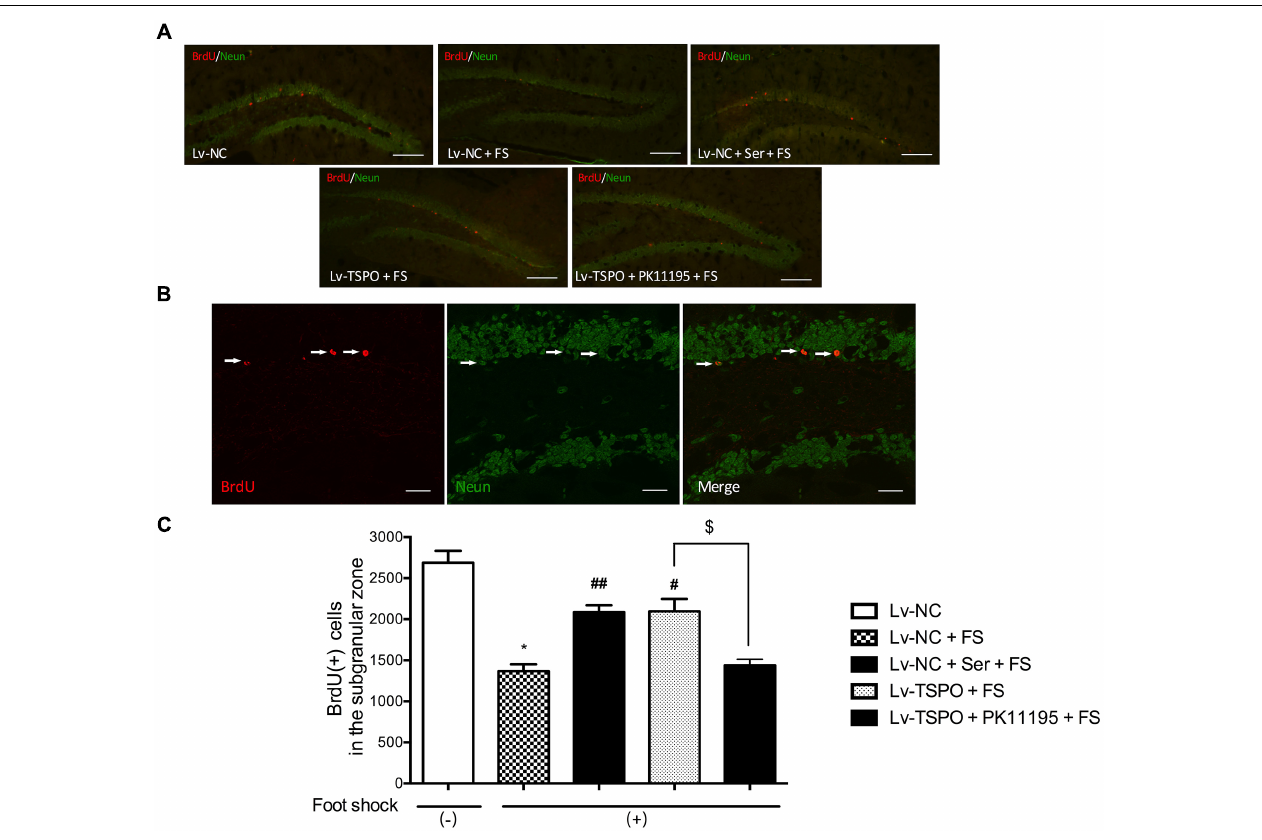
FIGURE 3 | Effect of TSPO overexpression in the DG on the number of BrdU-positive cells in the hippocampus in mice after electric foot-shocks. (A) A confocal laser-scanning microscope micrographs of BrdU-labeled cells (red) in the dentate gyrus of hippocampus. Scale bar = 200 µ m. (B) NeuN (green) and BrdU (red) co-labeled cells in the dentate gyrus were photographed and quantified under confocal microscope. Scale bar = 50 µ m. (C) Statistical analysis showed a significant decrease of the number of BrdU-positive cells in mice of foot-shock exposure (LV-NC + FS) compared with non-foot-shocked mice (Lv-NC), whereas it was prevented in the group of Lenti-GFP-TSPO injection (Lv-TSPO +FS). The improvement of Lv-TSPO was reversed by PK11195 (Lv-TSPO + PK11195 +FS). Data were presented as the means ± SEM ( n = 3). ∗ P < 0.05 compared with the Lv-N+foot-shock (–) group; # P < 0.05 compared with the Lv-NC+FS group; $ P < 0.05 compared with the Lv-TSPO+FS group. ## P < 0.01 compared with the Lv-NC+FS